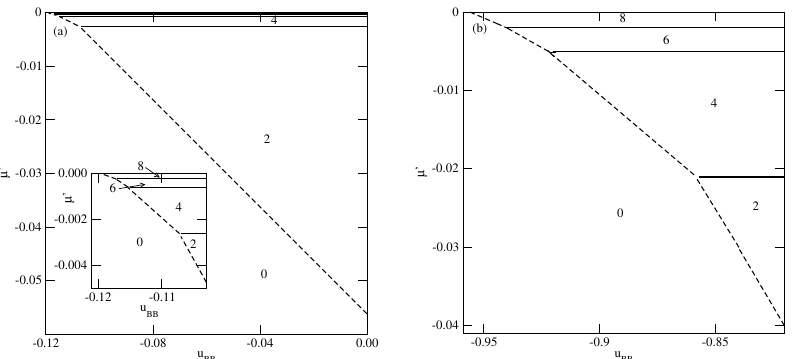
Figure 3. The ground state phase diagrams for the systems with V o = − 0.1 (part ( a )) and − 0.8 (part ( b )). The numbers in the figure mark the regions of different film thickness. The inset to part a shows the magnified upper left corner of the phase diagram. In part ( b ), only the region corresponding to u BB < − 0.82 is